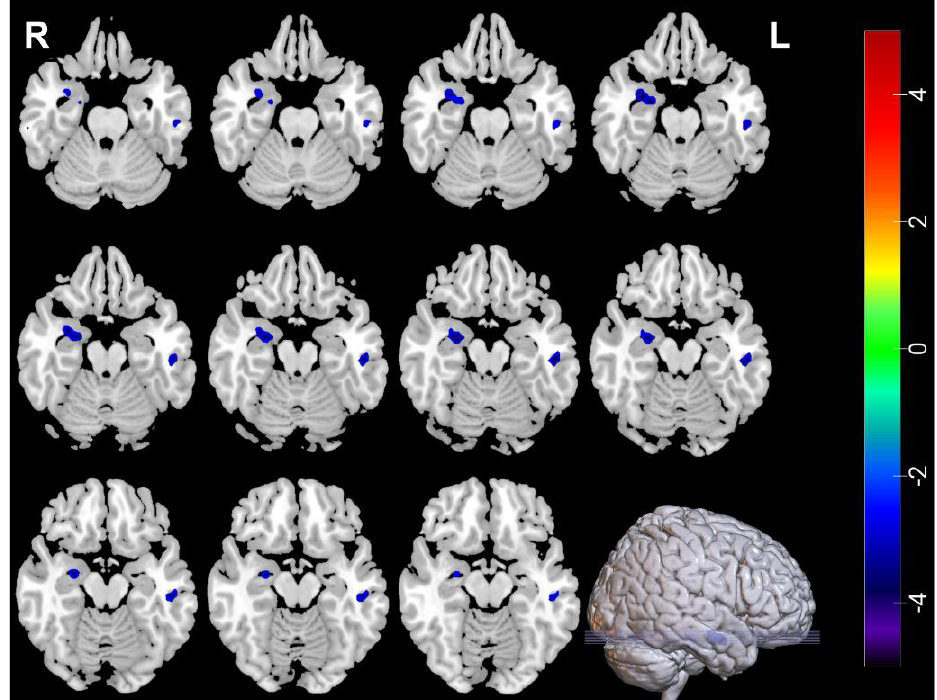
Figure 1. The blue regions mean decreased ALFF in Amygdala_R and Temporal_Inf_L between MDDs at baseline and HCs. ALFF voxel p < 0.005; GRF correction p > 0.05; cluster size > 24.